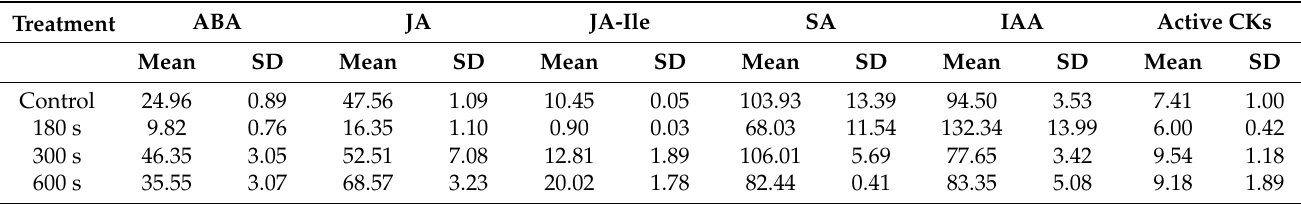
Table 2. The impact of Gliding Arc plasma treatment on hormonal levels. ABA—abscisic acid, JA—jasmonic acid, JA- Ile—jasmonate isoleucine, SA—salicylic acid, IAA—indole-3-acetic acid, active CKs—active cytokinins (trans-zeatin + isopentenyladenine + cis/zeatin). Mean and standard deviation (SD) are presented.